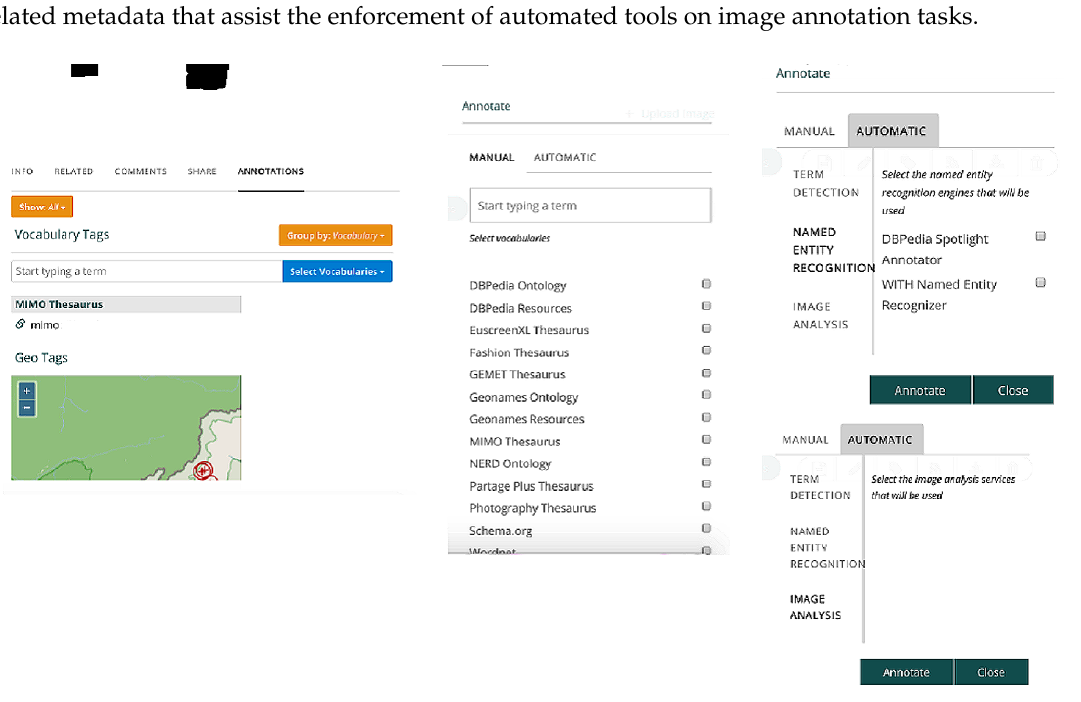
Figure 8. Manual annotation